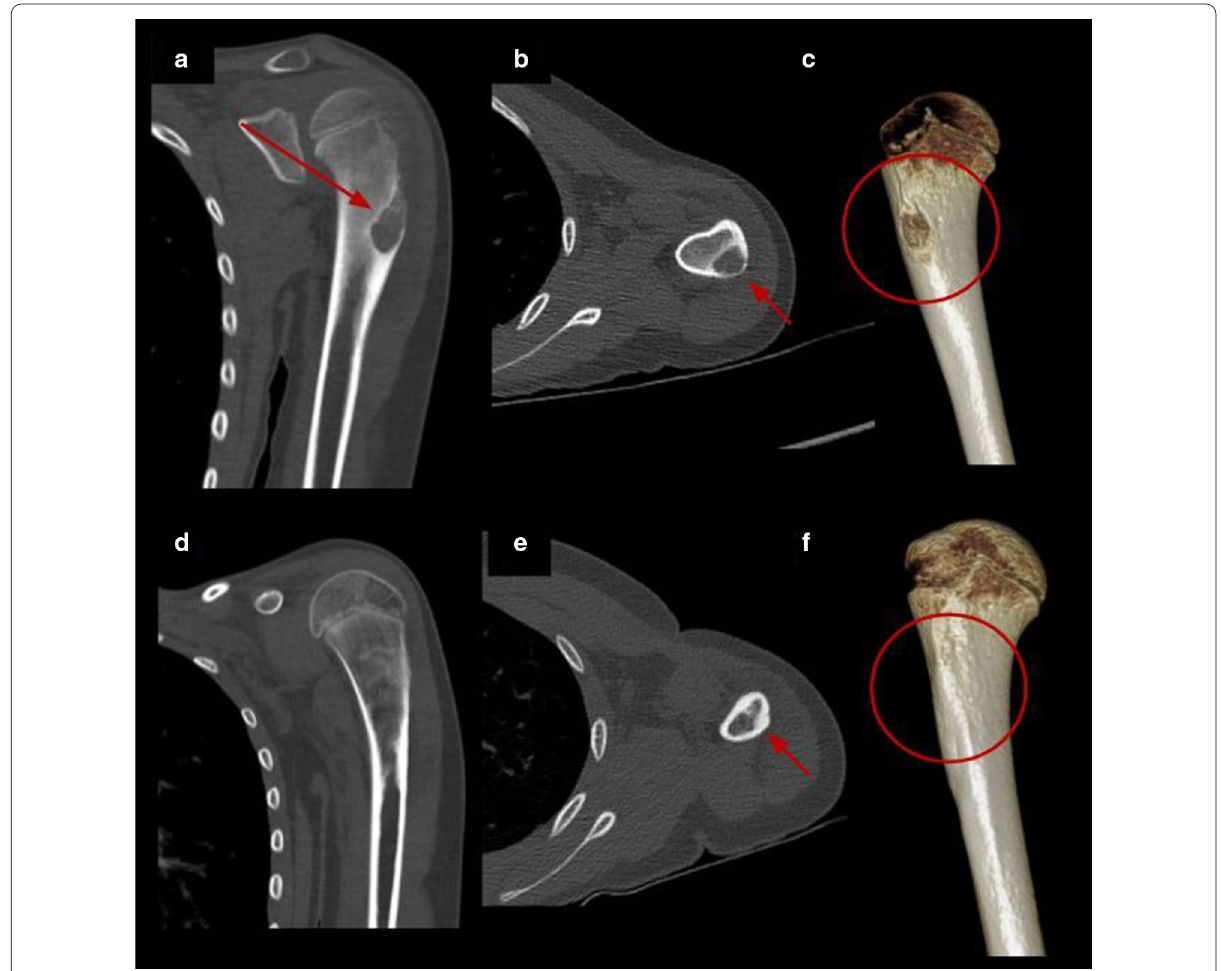
Fig. 4 Percutaneous cryoablation of humeral osteoblastoma in a 9‑y.o patient. a–c Coronal, axial CT images and volume rendering reconstruction of the left humerus show a lytic lesion consistent with osteoblastoma (red arrow and red circle). d–f Control CT 7 months after treatment with complete resolution of the lesion (red arrow and red